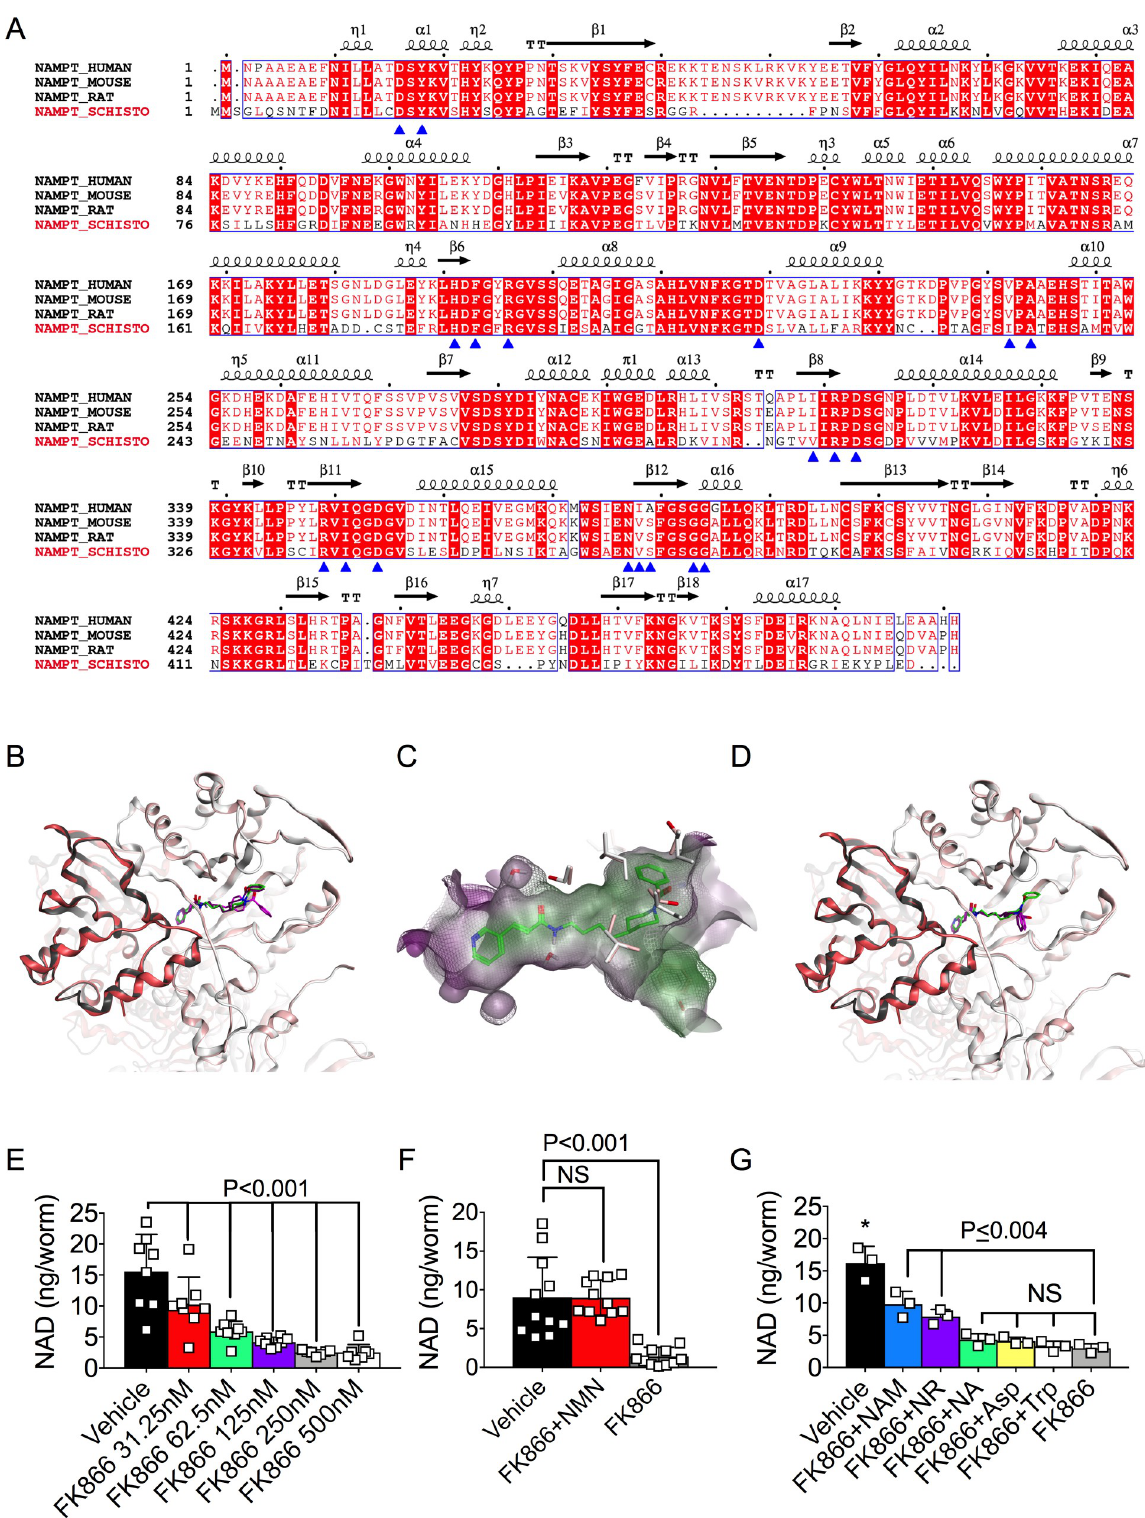
Fig 2. NAD biosynthesis in S . mansoni requires the NAD salvage pathway. (A) Structure-based sequence alignment of S . mansoni NAMPT with mammalian NAMPTs. Secondary structure elements are placed on top of the alignment according to the structure of R . norvegicus (rat) NAMPT in complex with FK866 (PDB 2G97 [42]). Residues interacting with FK866 [42] are indicated with blue arrows. (B-D) Best docking